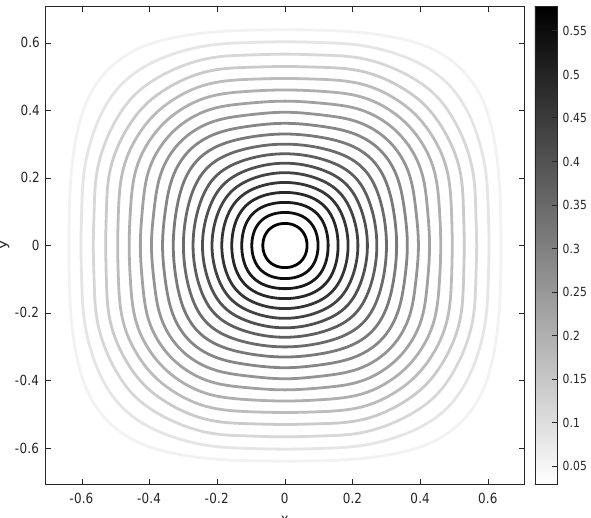
Figure 1: Approximated Optimal Control Figure 2. Compliancealong the iteration process. Figure 2: Compliance along the Figure 3: Approximation of the Figure 2: Compliance along the Figure 3: Approximation of the optimal estate optimal estate